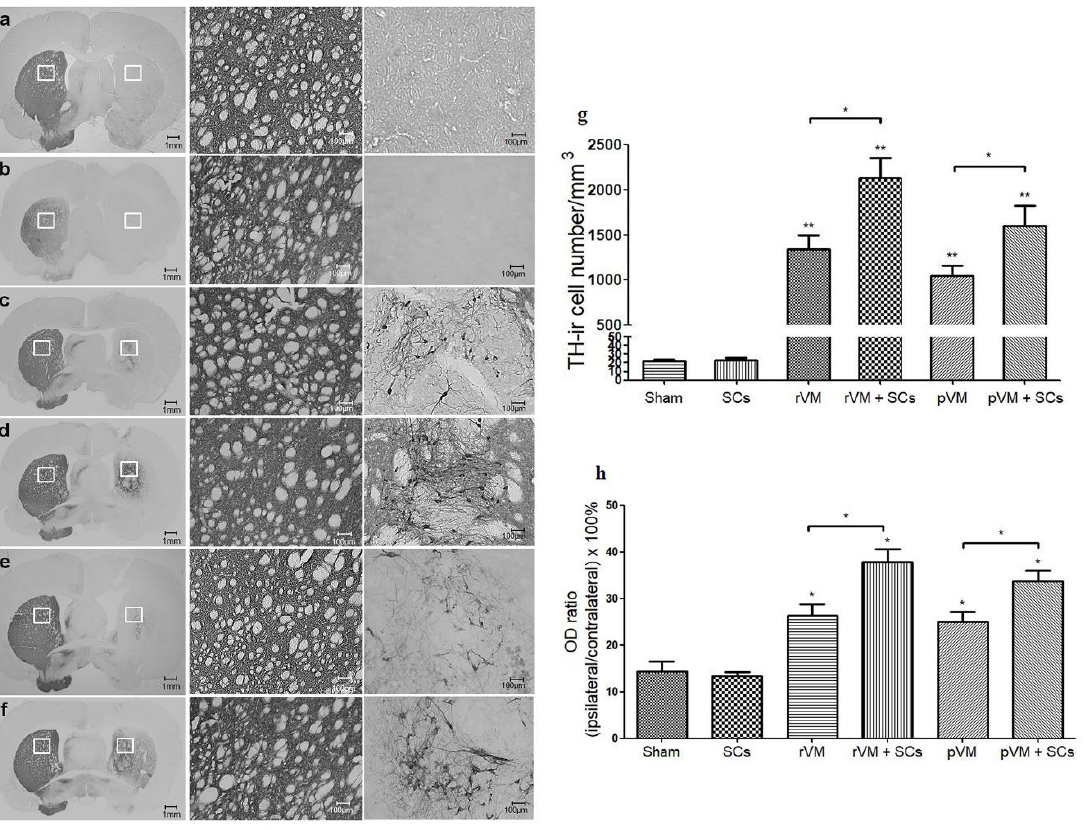
Figure 6. Photomicrographs of tyrosine hydroxylase immunoreactive (TH-ir) cells, and quantification results in hemiparkinsonian rat striatum at four weeks following transplantation. TH-ir cell bodies and fibers in the grafted side (right side of the coronal brain sections) of the rat ventral mesencephalic (rVM), rVM + SCs, pig ventral mesencephalic (pVM), and pVM + SCs groups. Greater densities of TH-ir cell bodies and fibers were noted in the rVM + SCs and pVM + SCs groups as compared to the rVM and pVM groups. Quantification data were consistent with the IHC results. ( a ) Sham group. ( b ) SC group. ( c ) rVM group. ( d ) rVM + SCs group. ( e ) pVM group. ( f ) pVM + SCs group. ( g ) Quantification of TH-ir cell density. ( h ) Optical density (OD) ratio in grafted striatum (* p < 0.05; ** p < 0.01).